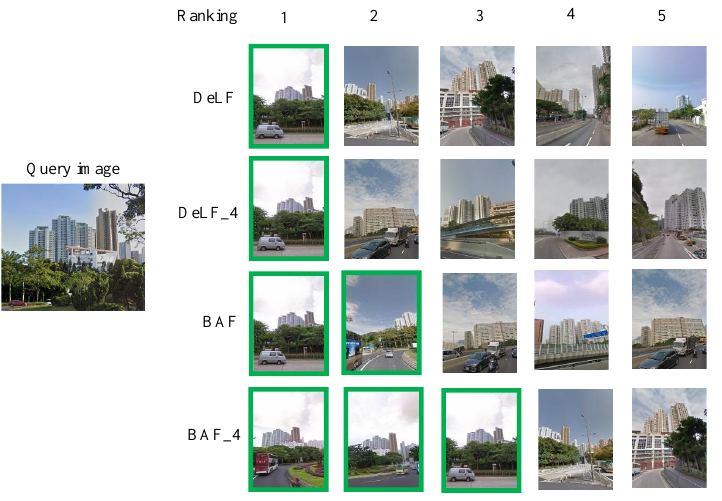
Figure 13. Top5 location result of same query image is used to show effectiveness of BAF descriptor.